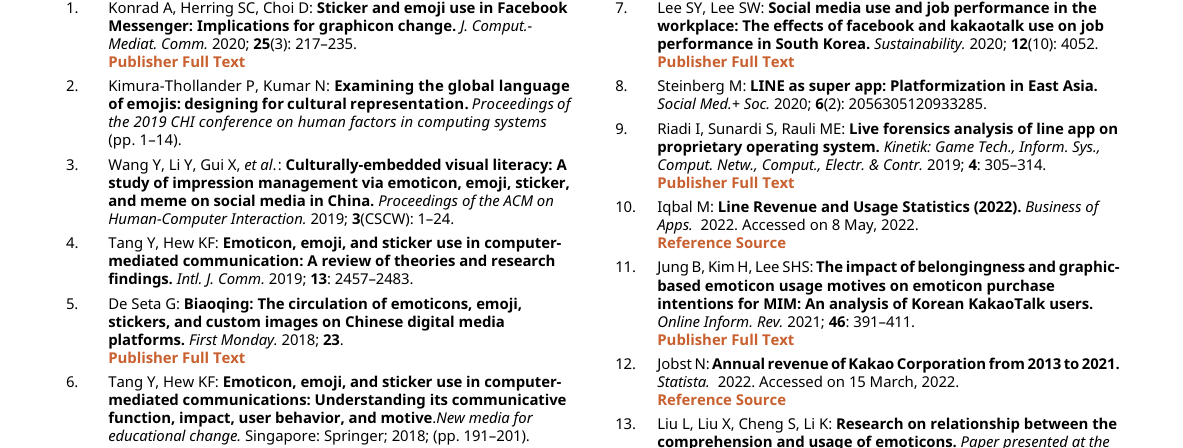
Figshare: Paid sticker article datasets. https://doi.org/10.6084/m9.figshare.20217719.v3. 64